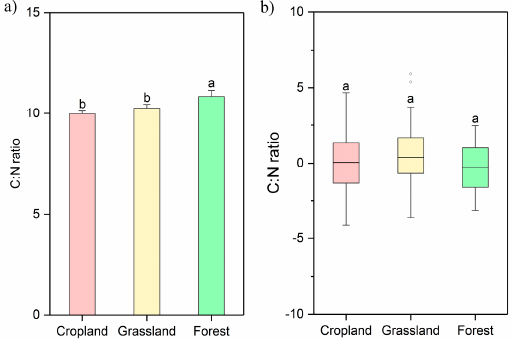
Figure 6. Soil C:N ratio for different prior land uses: ( a ) Values in 2015, ( b ) Changes from ca.1978 to 2015.